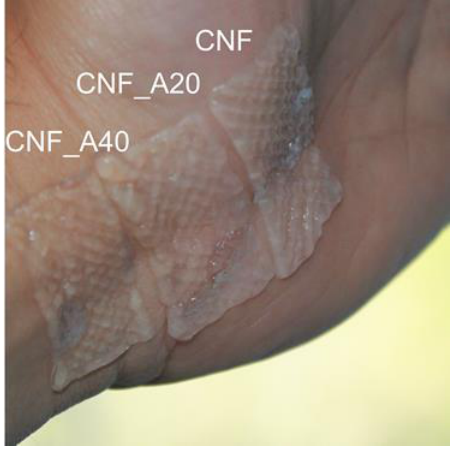
Figure 6. Wound dressings cross-linked with CaCl 2 (50 mM). Note the relatively large shrinkage of the samples containing alginate. The target dimensions of the 3D printed structures were 20 mm × 40 mm.